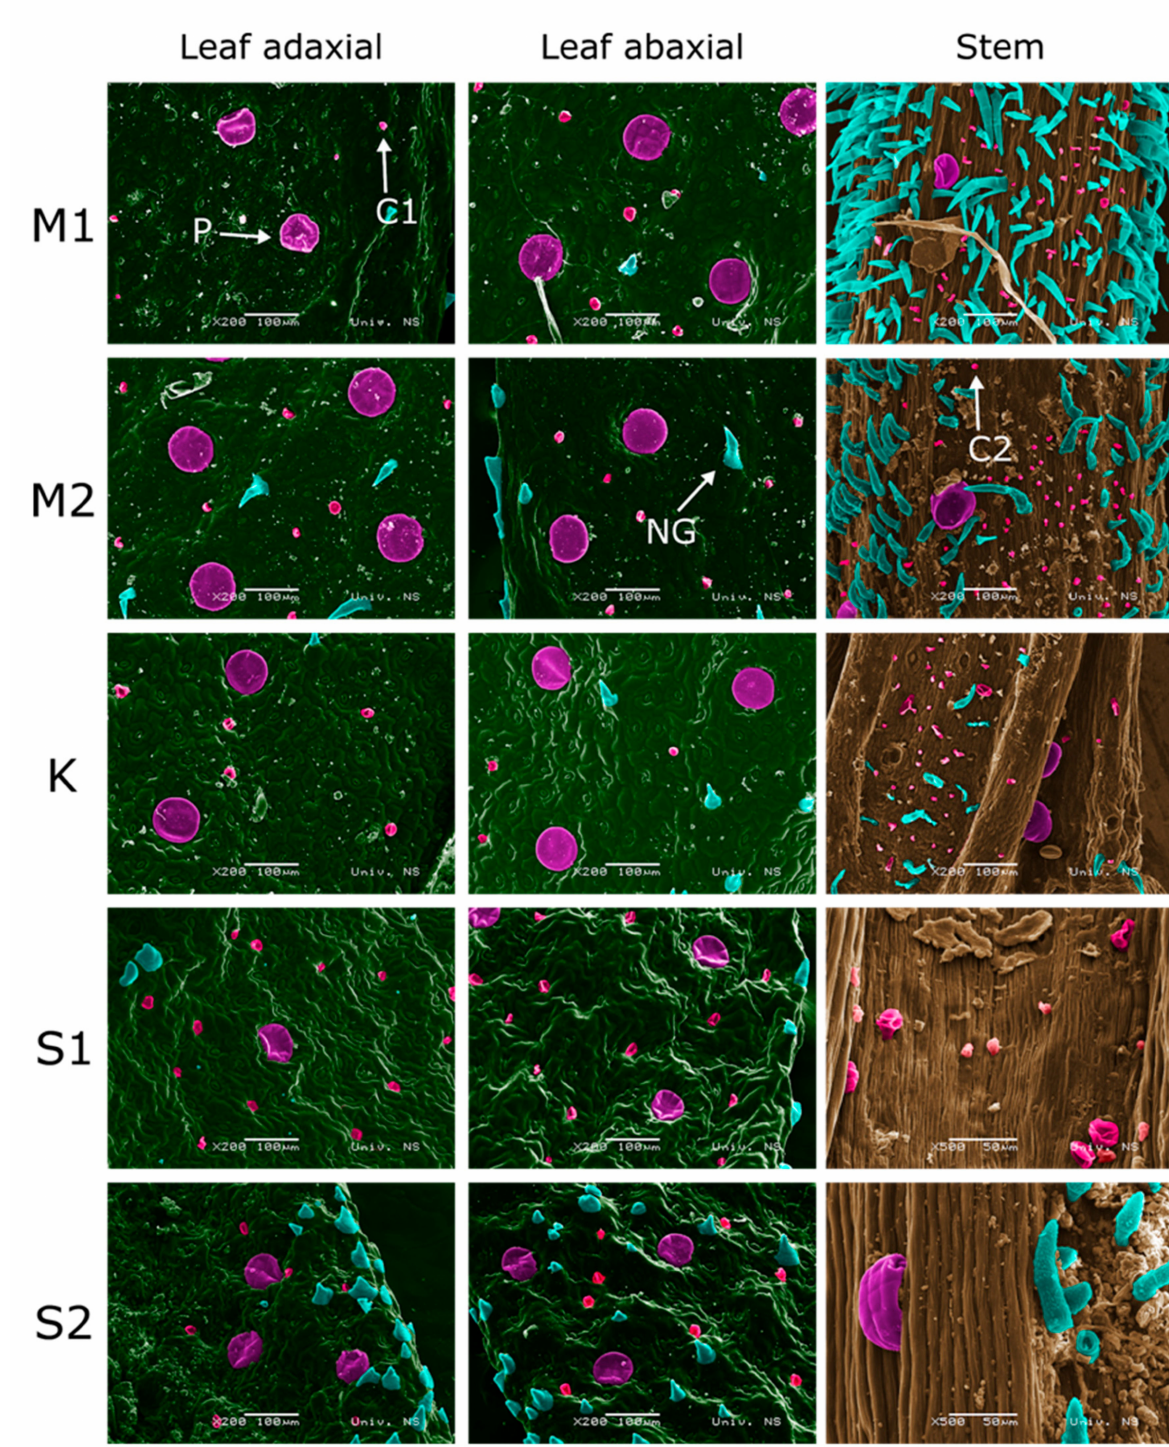
Figure 4. Scanning electron micrographs of M1: S. montana continental; M2: S. montana coastal; K: S. kitaibelii ; S1: S. subspicata subsp. liburnica ; S2: S. subspicata subsp. subspicata , leaves and stems. P: Peltate trichomes; C1: Type 1 capitate trichomes; C2: Type 2 capitate trichomes; NG: Non-glandular trichome; SEM micrographs colored using Portable Photoshop CS6. Unlike peltate trichomes, capitate C1 and C2 show organ preference. Capitate tri- chomes (C1) resemble peltate trichomes, with basal and neck cells sunken into the epider- mis, but are three times smaller (20 ± 4 µ m). This type of glandular trichomes was present on the leaves in all samples, being more numerous on the abaxial leaf side (Figure